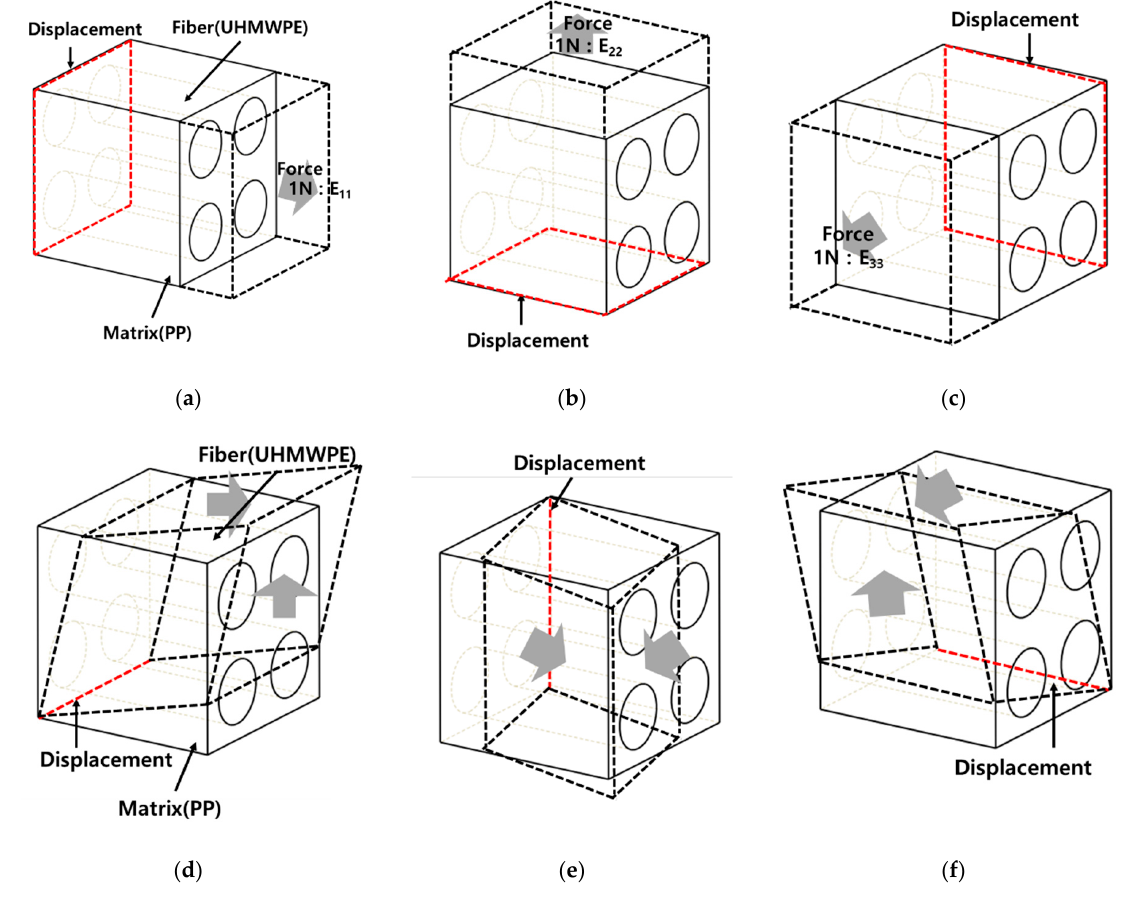
Figure 3. Boundary conditions for FEA. ( a ) E 11 Young’s modulus, ( b ) E 22 Young’s modulus, ( c ) E 33 Young’s modulus, ( d ) G 12 Shear modulus, ( e ) G 13 Shear modulus, ( f ) G 23 Shear modulus.